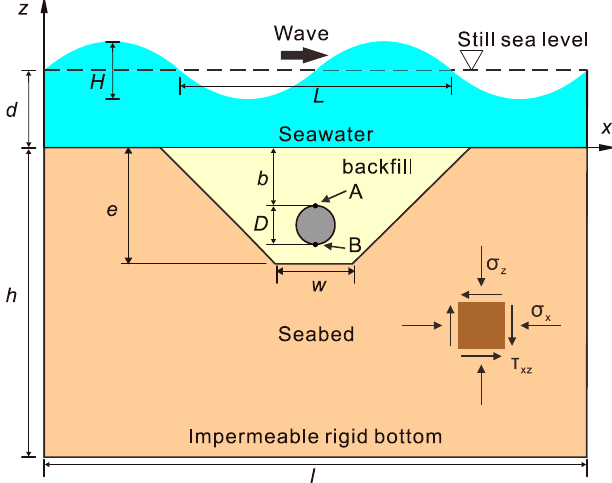
Figure 4. Schematic diagram of numerical model (not to scale).